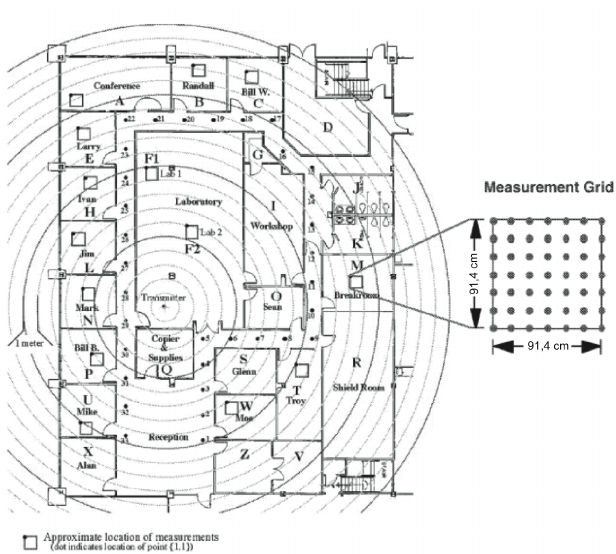
Figure 1: Scheck of the office/building used for UWB measurements, taken from [1] with permission of the